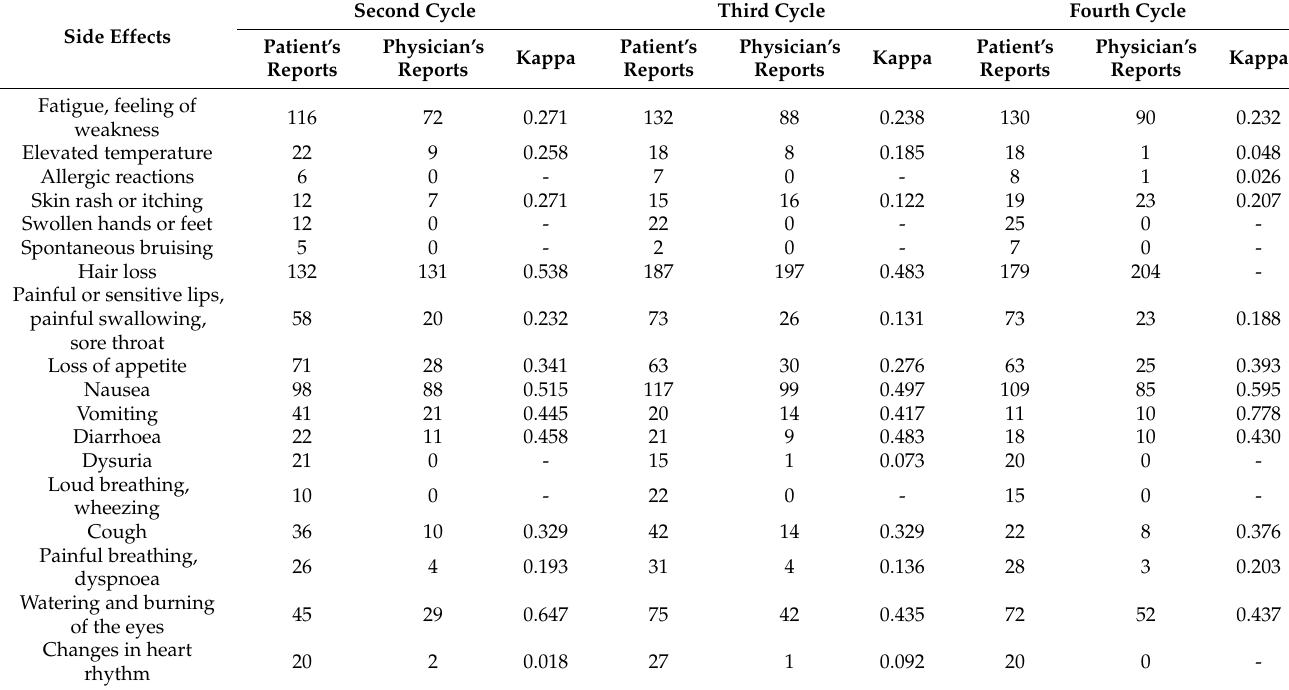
Table 2. Comparison of the intensity of reported side effects among patients and kappa coefficients for comparisons of the second, third and fourth treatment cycles.